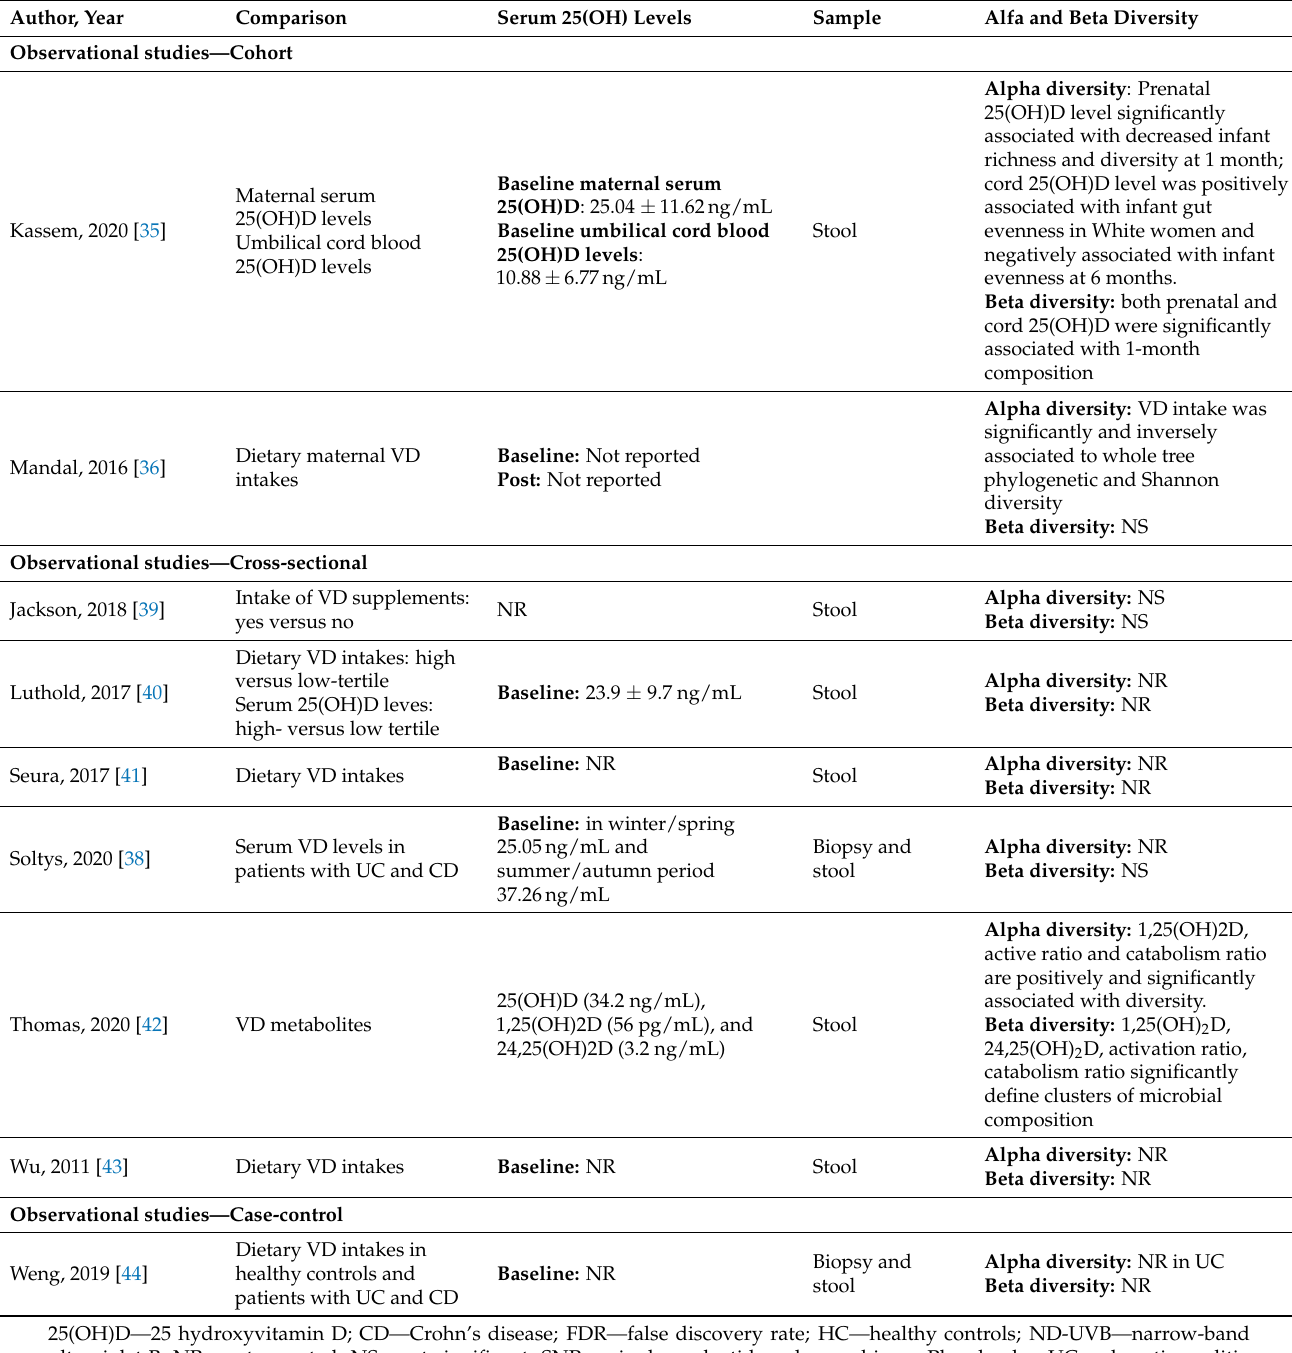
Table 3. Results of selected studies on alpha and beta diversity with Vitamin D Intake or Serum